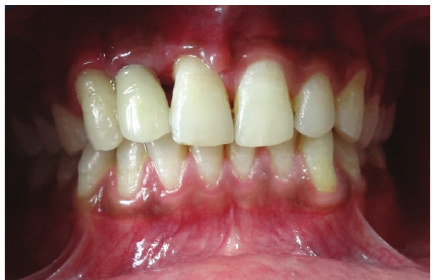
Figure 12: Restored implant 1 year after